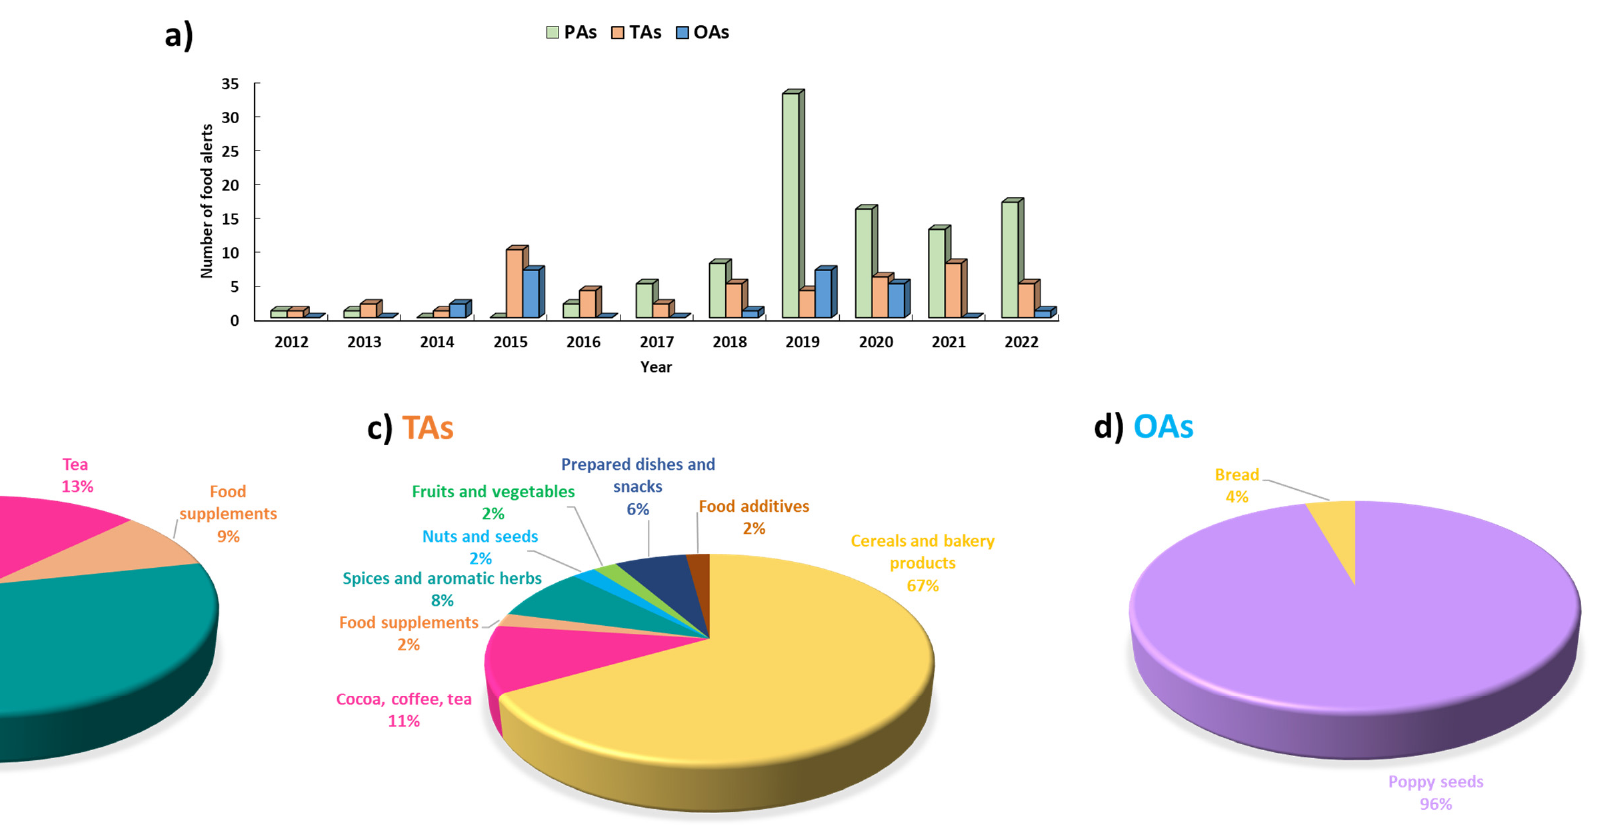
Figure 1. ( a ) Evolution in the number of food alerts that have noted high levels of pyrrolizidine alkaloids (PAs), tropane alkaloids (TAs) and opium alkaloids (OAs) from 2012 to 2022; Distribution of food alerts related to ( b ) PAs, ( c ) TAs and ( d ) OAs based on the food type contaminated (data obtained from Rapid Alert System Feed and Food (RASFF) portal, 2022 [9]).